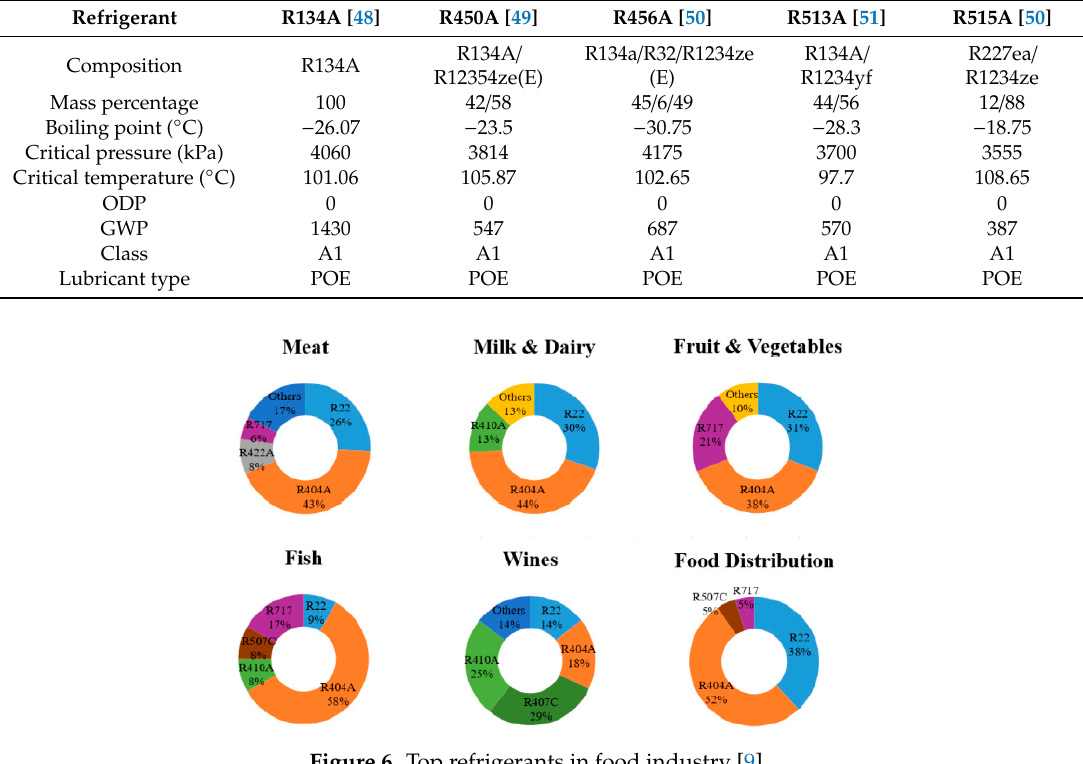
Figure 6. Top refrigerants in food industry [9].